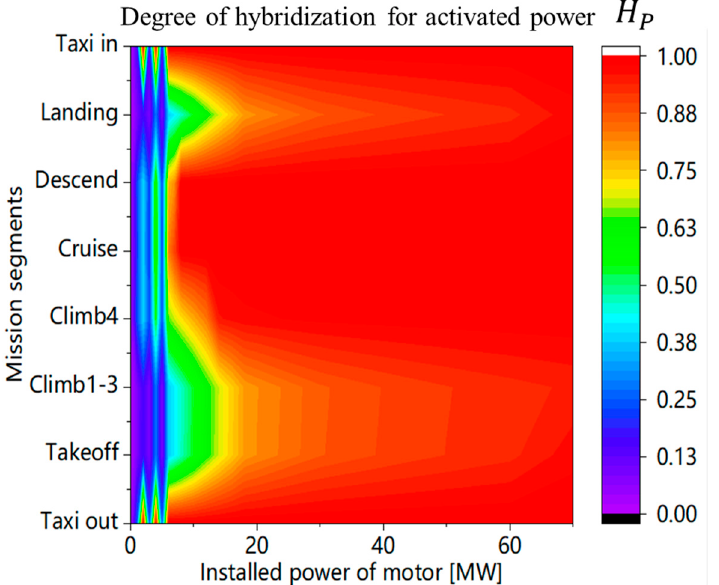
Figure 11. The variation of 𝑯 𝑷 for complete flight conditions of HEA with different levels of EM power.